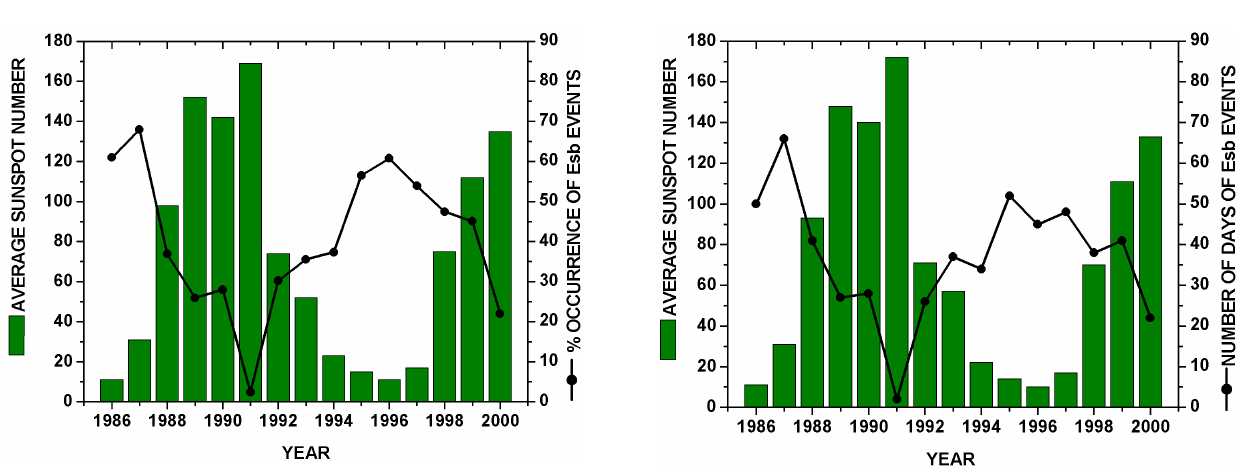
Fig. 3b. Distribution of the total number of occurrence of the E sb events during the solstitial months with the average sunspot num- bers corresponding to these days of the months of each year from 1986–2000. Magnetically quiet days with A p ≤ 15 are included in the